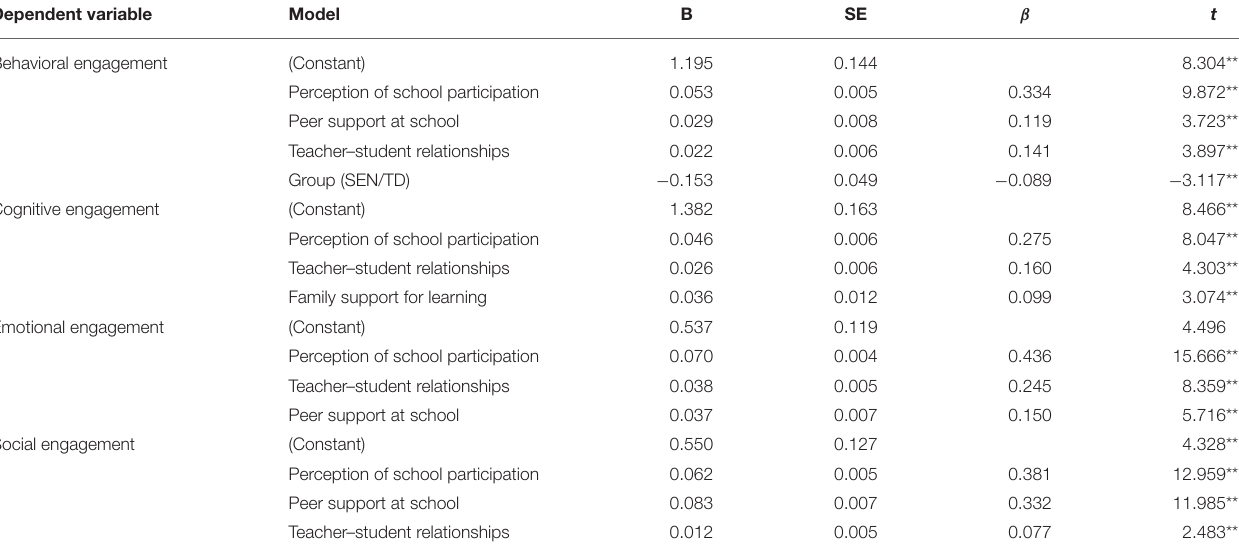
TABLE 2 | Linear regression models for behavioral, cognitive, emotional, and social engagement dimensions. Dependent